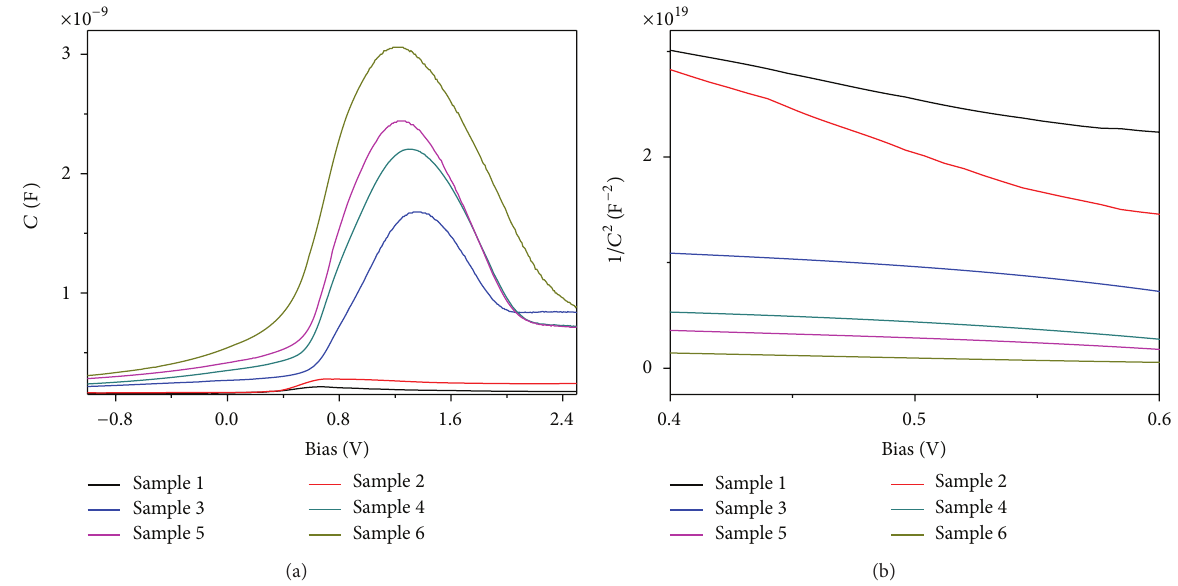
Figure 3: (a) 𝐶 versus 𝑉 curves for cells. (b) Plots of 𝐶 −2 versus 𝑉 under the range of 0.4 V–0.6 V with CdS/CdTe junction conforming depletion layer approximation and processed according to unilateral abrupt